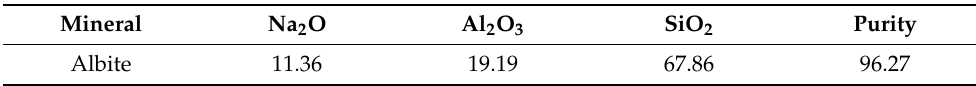
Table 2. Chemical composition of pure albite mineral (wt %).